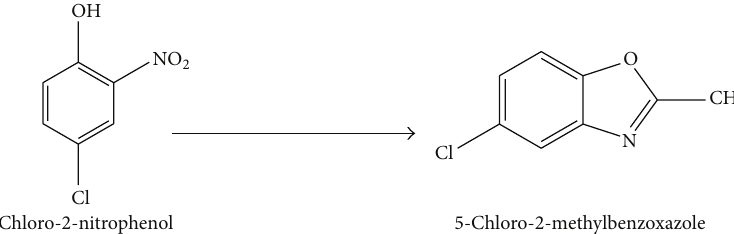
Figure 6: Biotransformation of 4-chloro-2-nitrophenol to